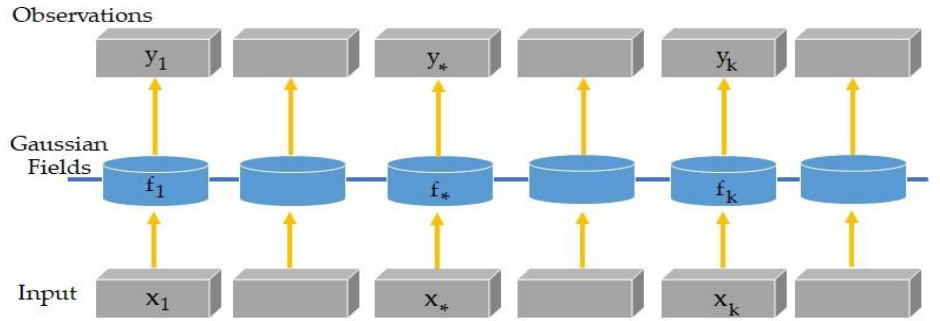
Figure 4. Graphical representation of GPR.